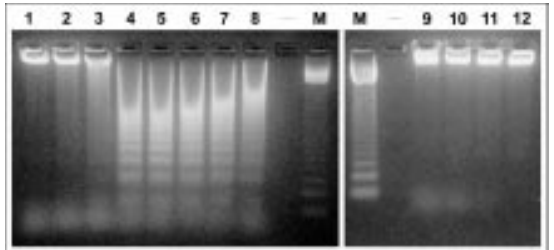
Fig. 9. Agarose gel electrophoresis of DNA extracted from HL60 cells after exposure to UV irradiation and further incubation during 4 h at 37 (cid:14) C. DNA fragmentation typical of apoptosis (DNA ladder) was observed in cultures irradiated during 15 sec (lane 4), 30 sec (lane 5), 1 min (lane 6), 3 min (lane 7) and 5 min (lane 8). No spe- cific DNA cleavage was shown in control cultures (lane 1) and in cultures exposed to 1 sec (lane 2), 3 sec (lane 3), 10 min (lane 9), 15 min (lane 10), 25 min (lane 11) and 1 h (lane 12) of UV irradi- ation. M lanes represent a molecular weight size standard (100 base pairs). One representative experiment out of three is